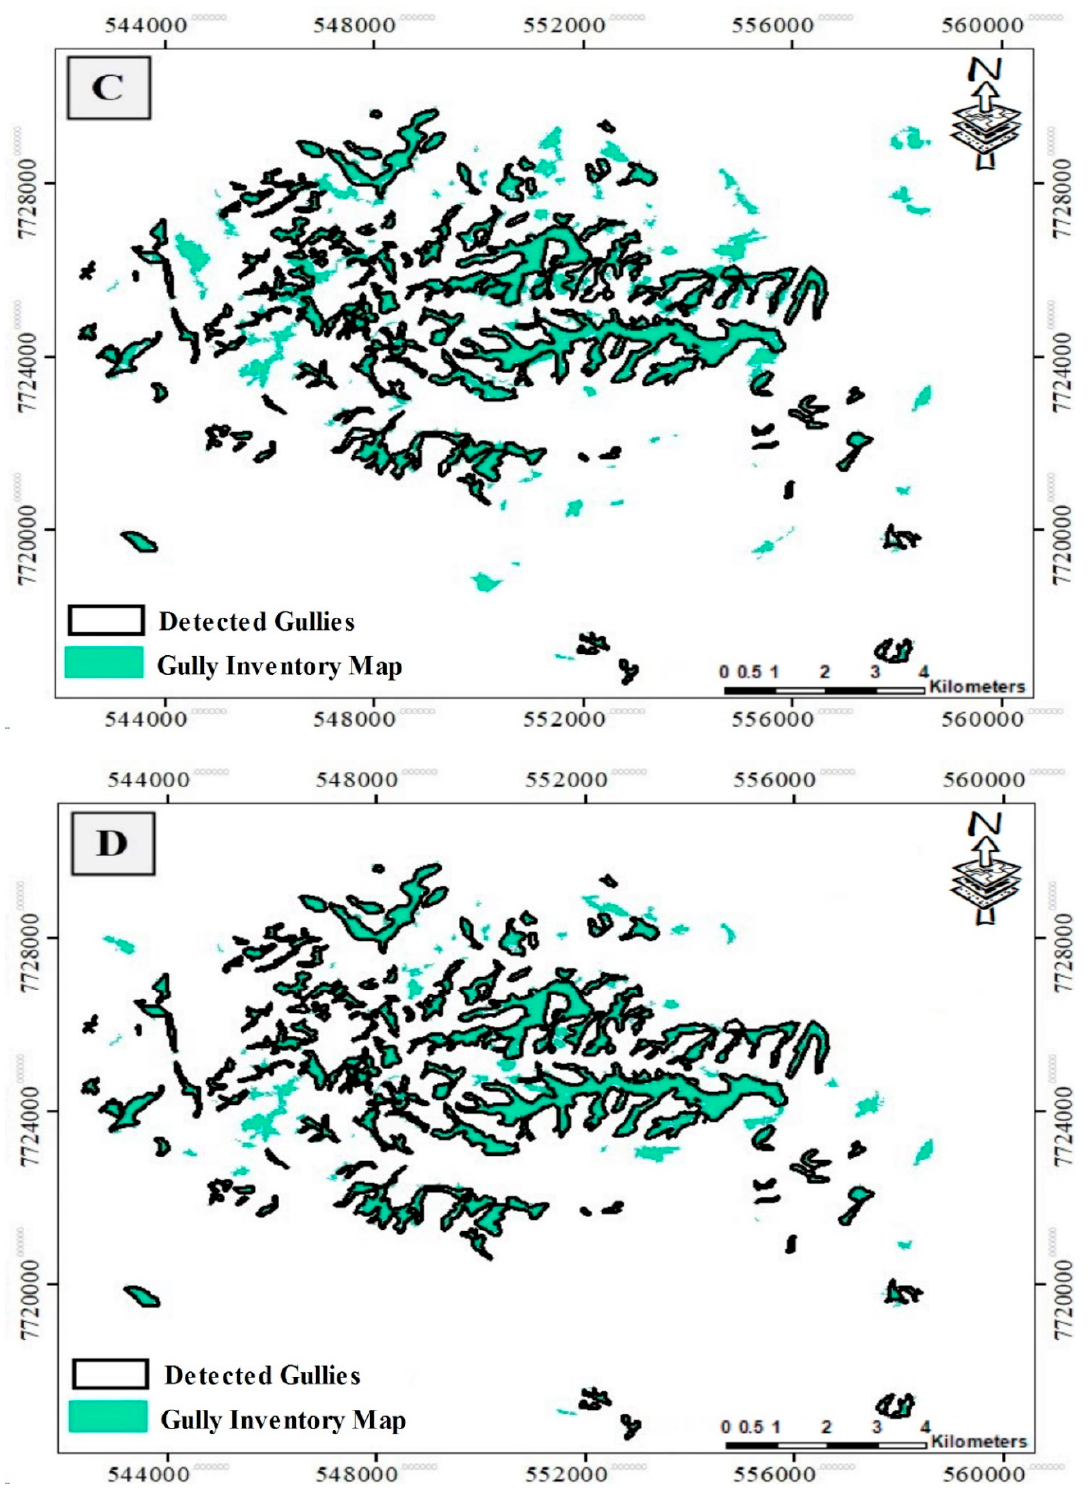
Figure 9. The results of gully networks detection based on segmentation scale 45: ( A ) SVM, ( B ) ANN, ( C ) RF, and ( D ) stacking model. The black color indicates detected gullies, and cyan polygons represent the gully inventory map.